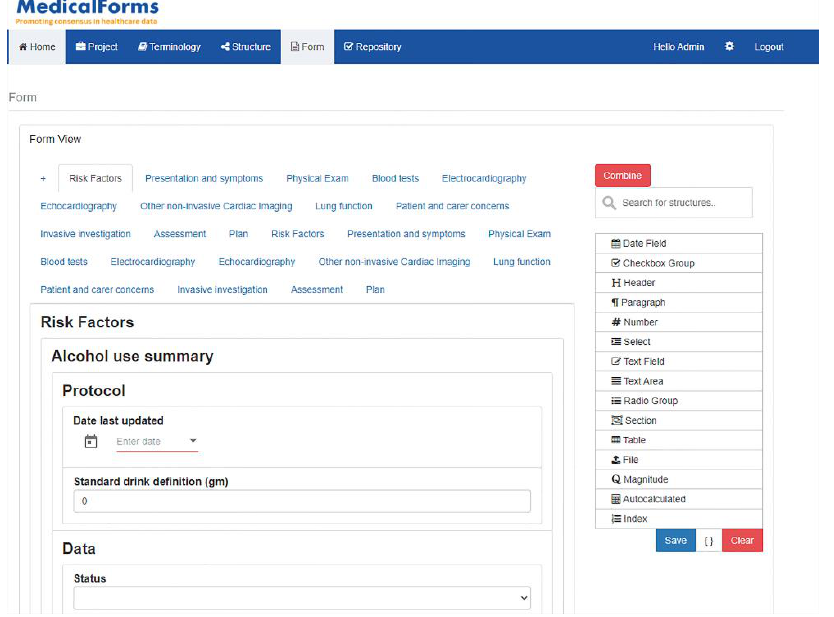
Figure 5. Representation of the Heart Failure Clinic’s First Visit Summary Form with multiple tabs for each section (v.1).